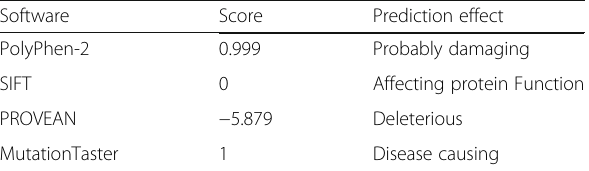
Table 2 In silico prediction of the MMAA c.365T>C variant